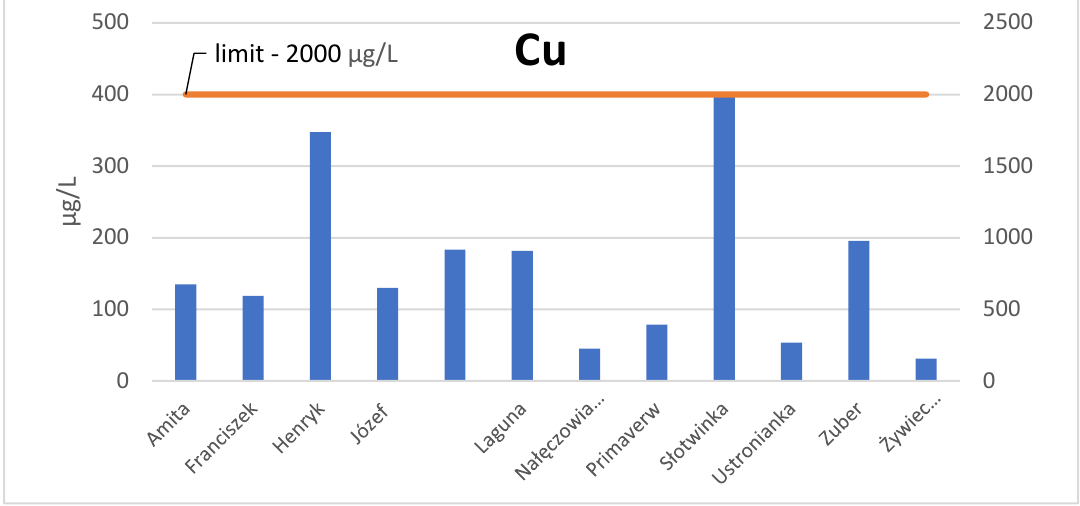
Figure 10. The concentration of copper in mineral waters ( μg/L ).